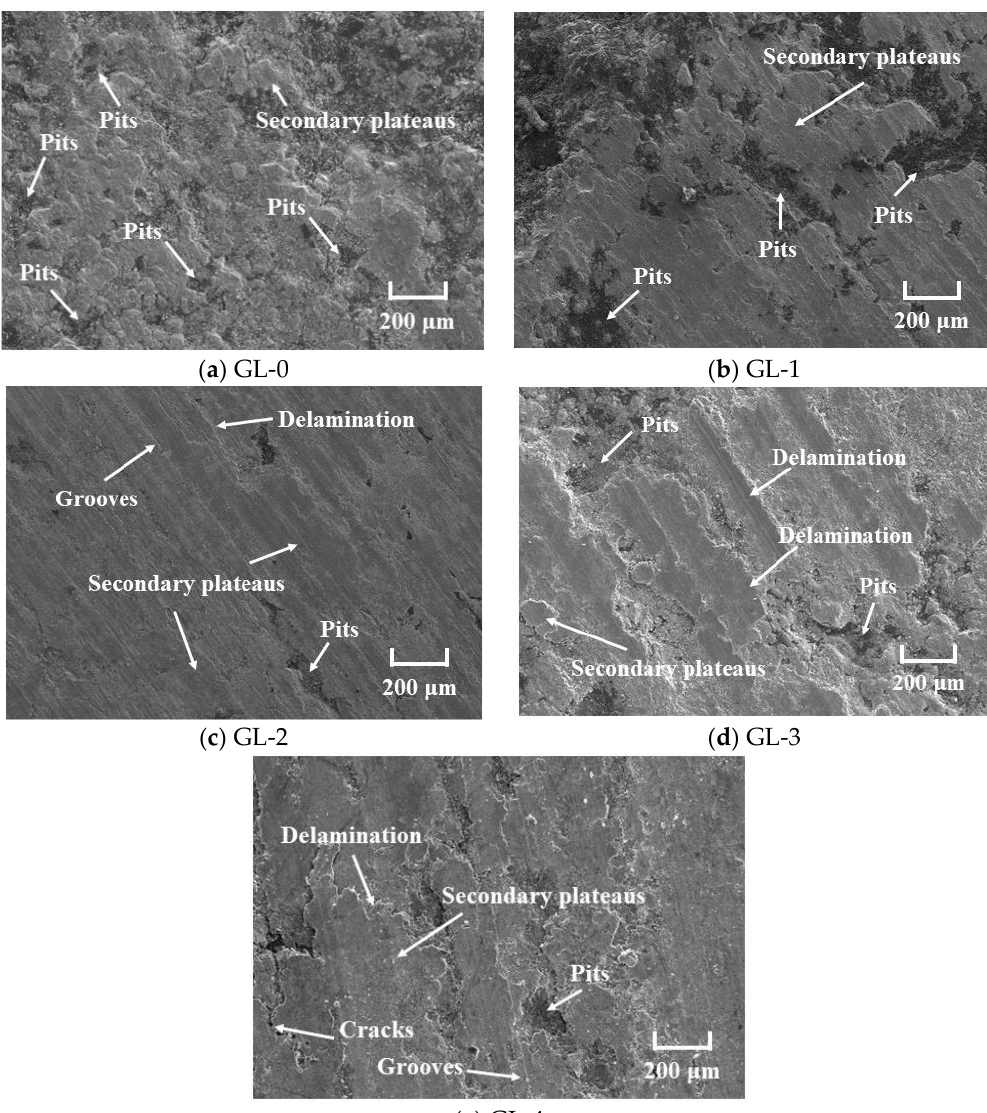
Figure 5. SEM micrographs of worn surfaces.